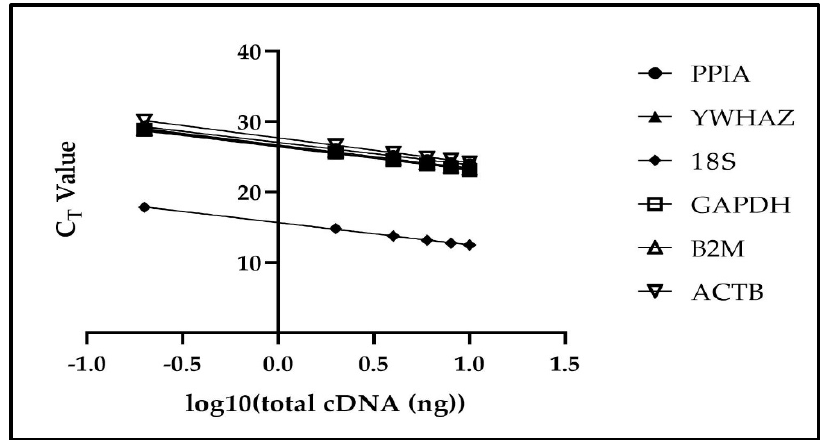
Figure 1. Standard curves of the threshold cycle value (C T ) versus the log of the total cDNA (ng) for the 6 potential reference genes considered in this study. Table 2. Standard curve parameters and primer efficiencies of each potential reference